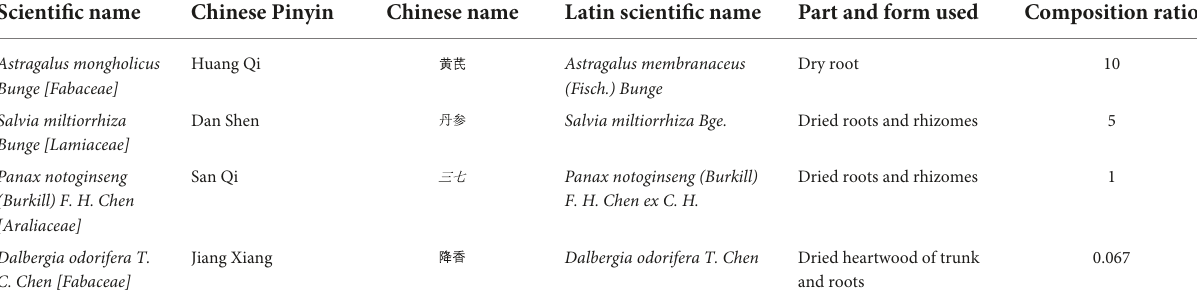
TABLE 1 Components of